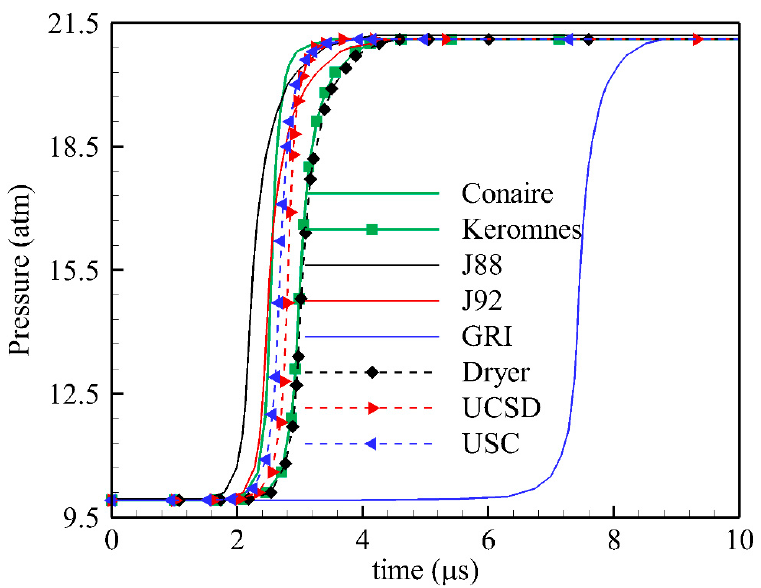
Figure 8. Pressure profile for various reaction mechanisms calculated from the CV explosion model. Table 1. Ignition delays calculated from the constant volume explosion model.